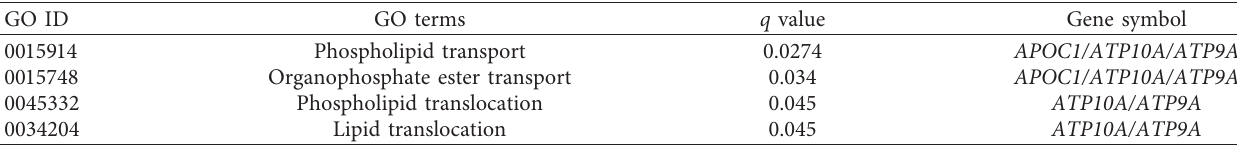
Figure 9: 2D structure of putative candidate small-molecule drugs against APA. Table 2: GO enrichment analysis of real hub genes using the clusterProfiler package